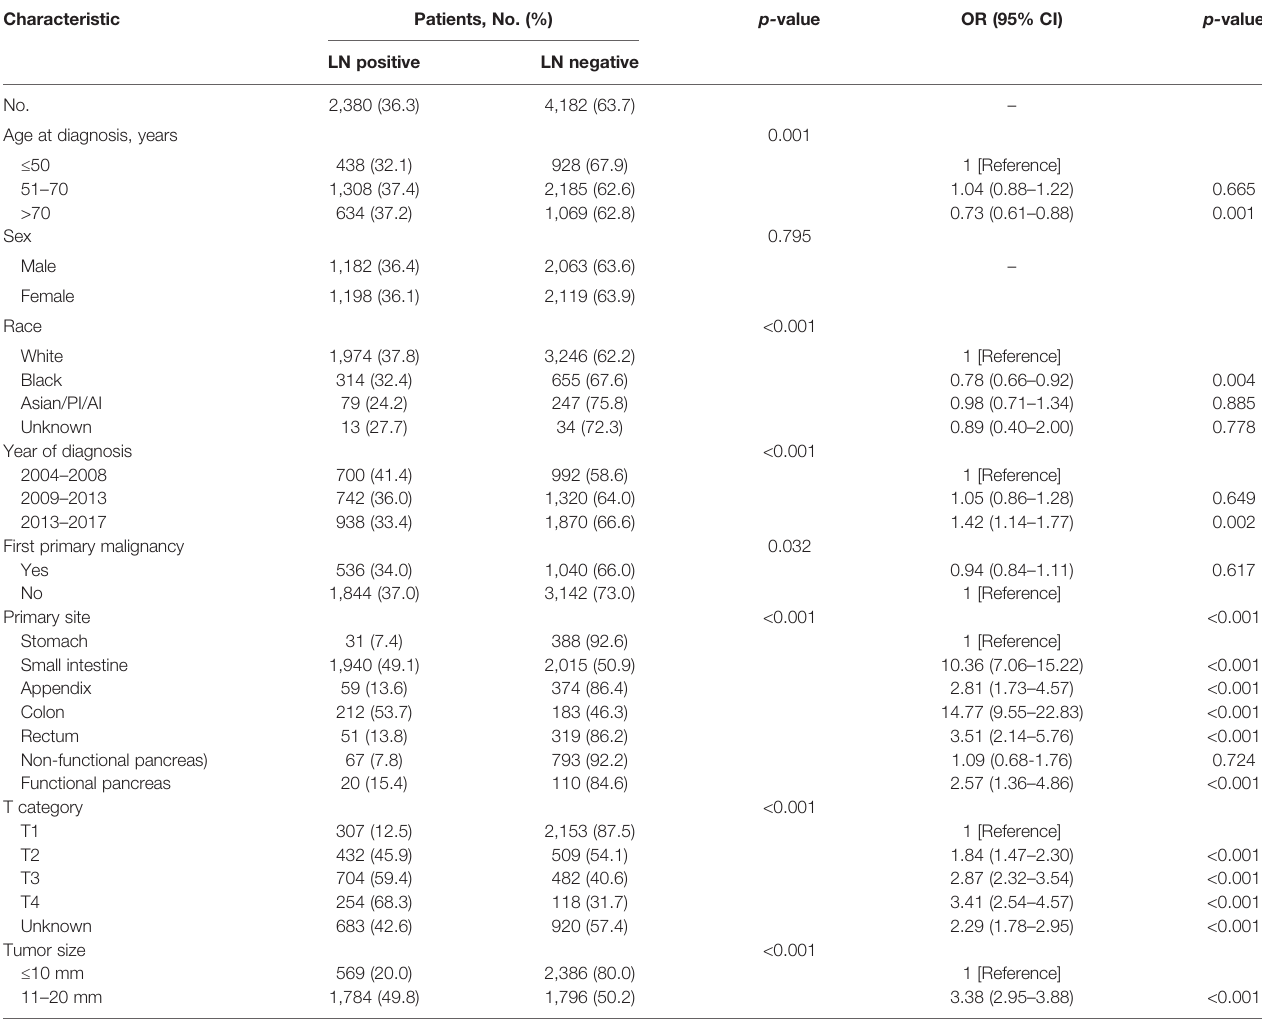
TABLE 1 | Demographics of patients strati fi ed by LN status and clinicopathologic characteristics associated with LN metastasis. Characteristic Patients, No.